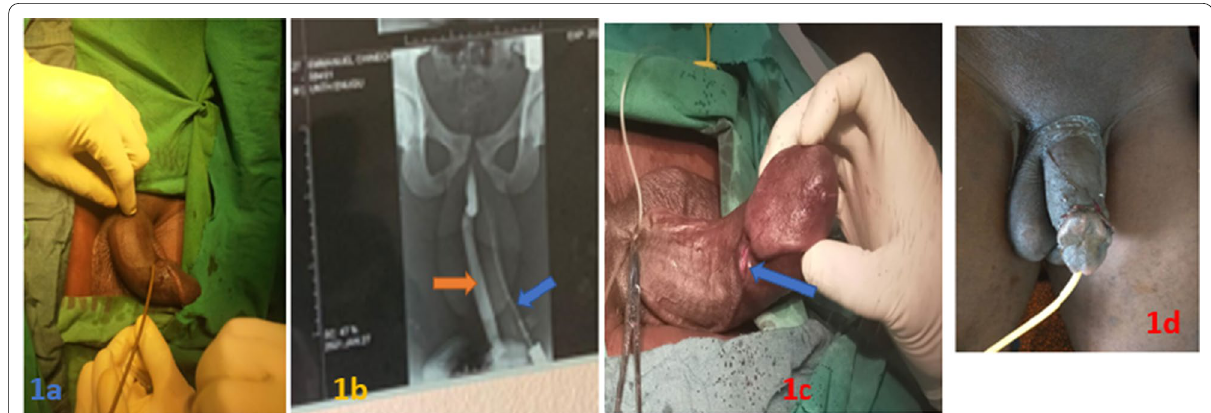
Fig. 1 Pre-op and post-op appearances of the penis a pre-op penis at rest; b combined retrograde urethrography {orange arrow} and fistulography {blue arrow}; c appearance of the penis with artificial erection intra-op showing the dorsal meatus {blue arrow}; d appearance of penis 5th day post-op